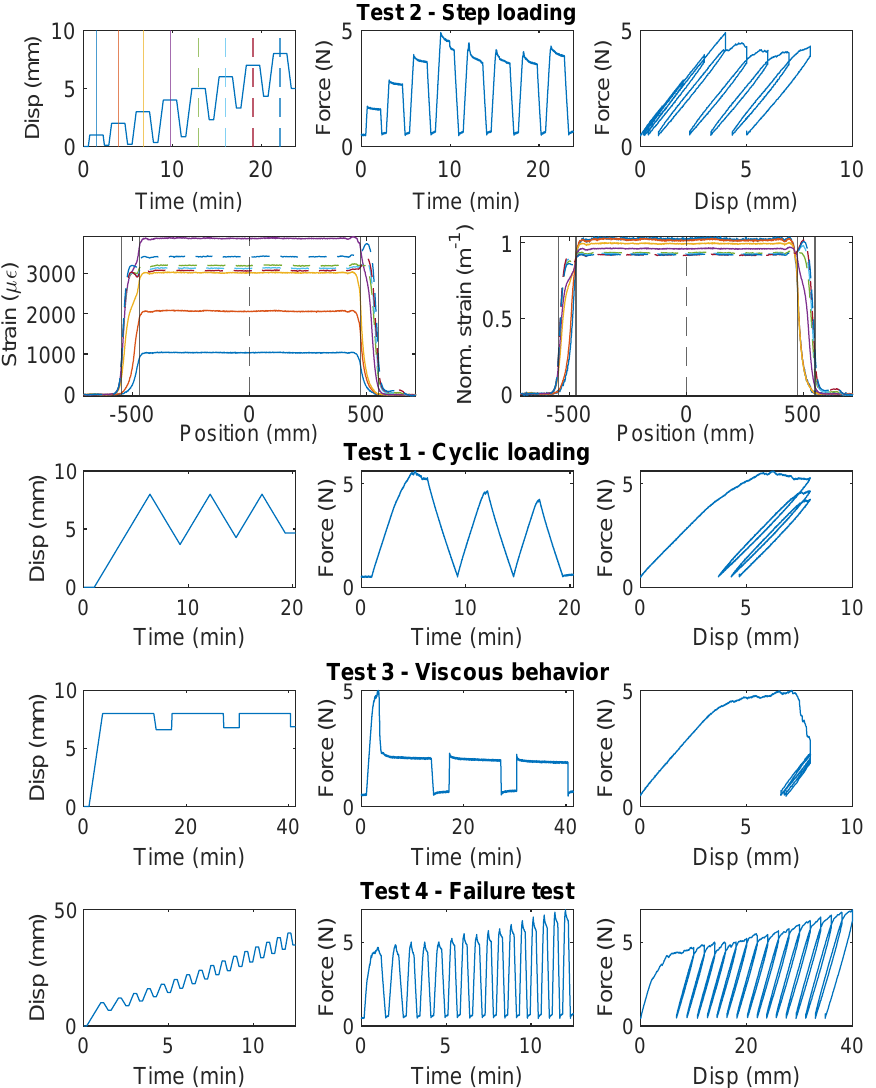
Figure 11. The loading protocol, force–displacement relation and strain distributions under increasing displacement levels (represented by different color lines) for Specimen 3 of the PVC 0.9 mm